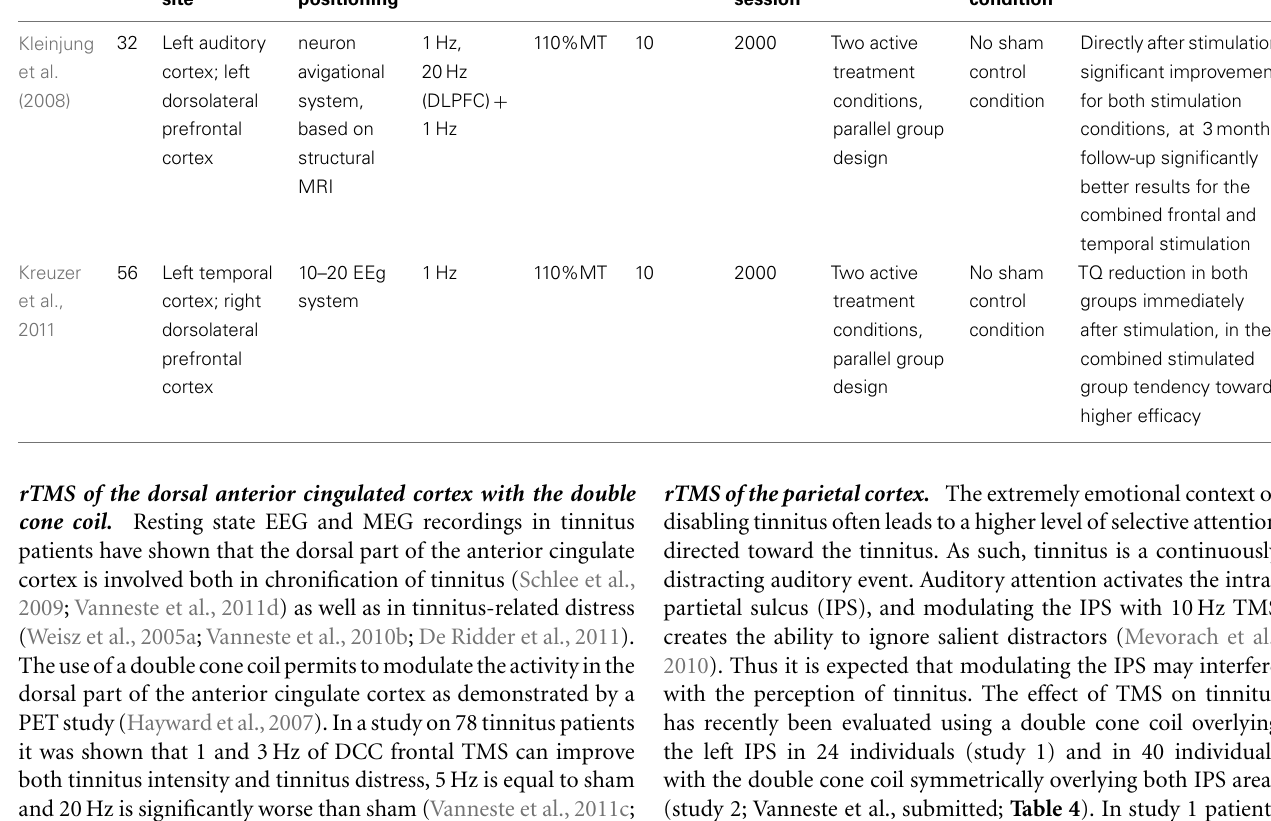
Design Control session condition